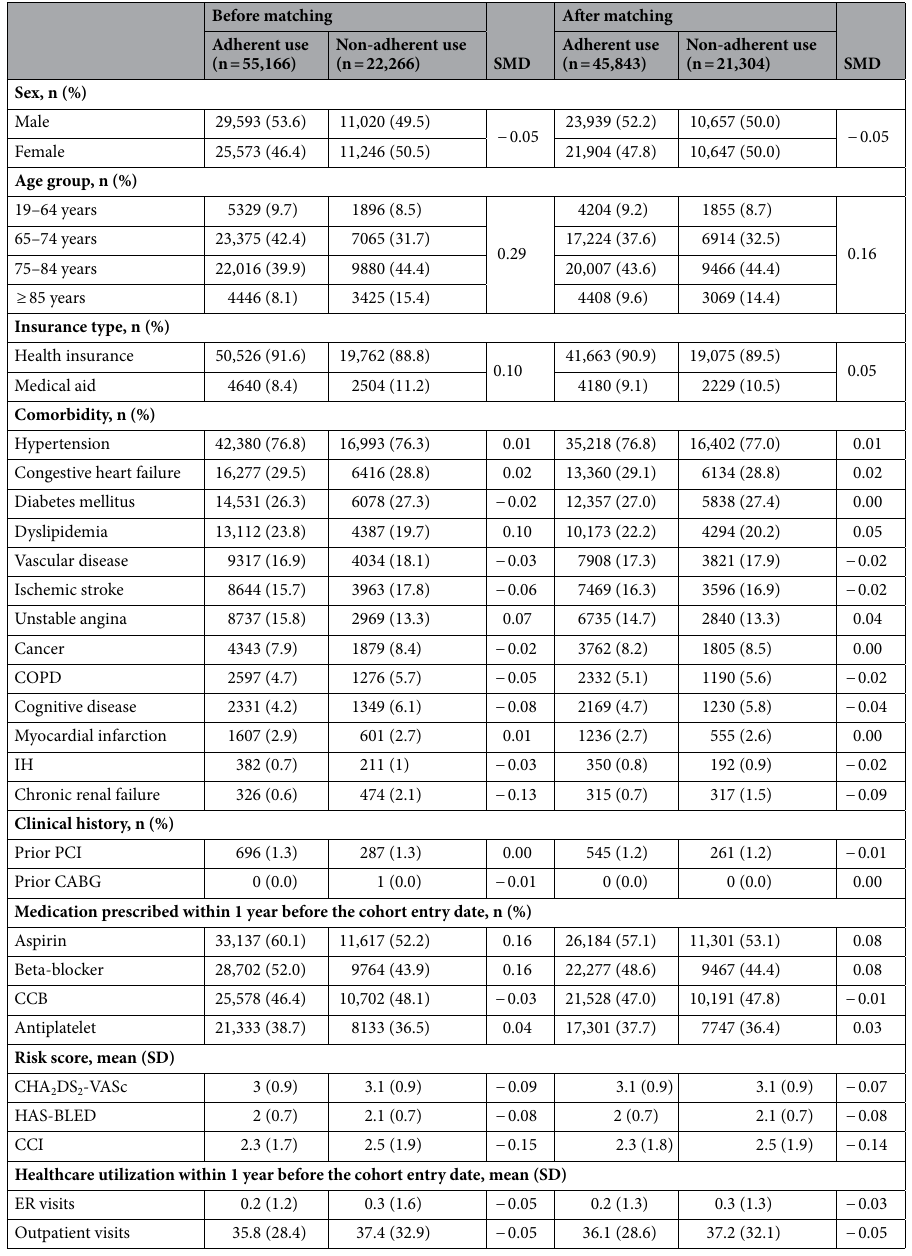
Table 1. Baseline characteristics of adherent and non-adherent oral anticoagulant (OAC) users before and after propensity score matching. SD, standard deviation; SMD, standard mean difference; PCI, percutaneous coronary intervention; CABG, coronary artery bypass grafting; COPD, chronic obstructive pulmonary disease; TIA, transient ischemic attack; TE, thromboembolism; IH, intracranial hemorrhage; CCI, Charlson comorbidity index; ER, emergency room; CCB, calcium channel